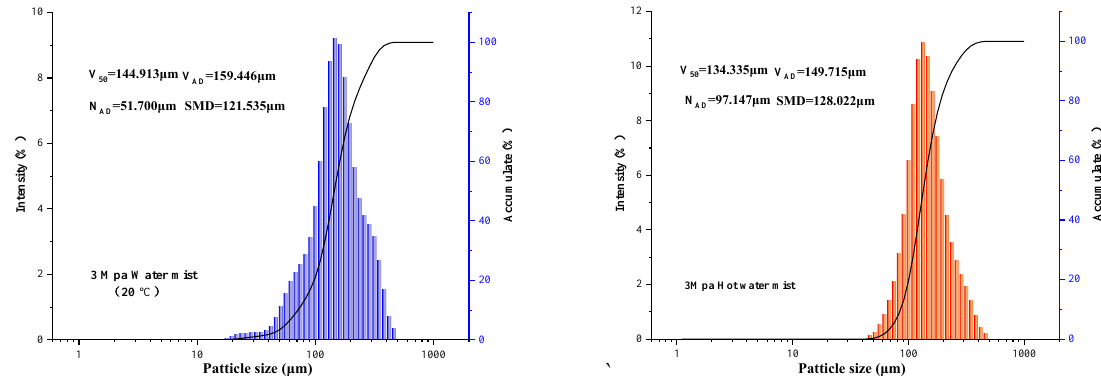
Figure 2. Particle size distribution of 20 °C and 80 °C water mist at 1 MPa .